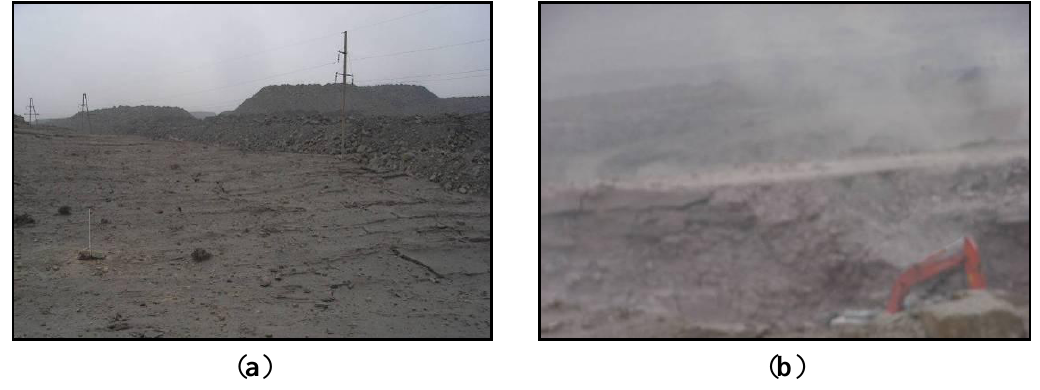
Figure 7. Field survey pictures of the authentication area showing ( a ) a new subsiding area (area A marked in Figure 6) caused by coal fire burning, which was identified as coal fire zone 18 by the Wuda Mine Bureau, and ( b ) a coal mining area (area B marked in Figure 6) where intensive coal extraction activity was carrying out with longwall